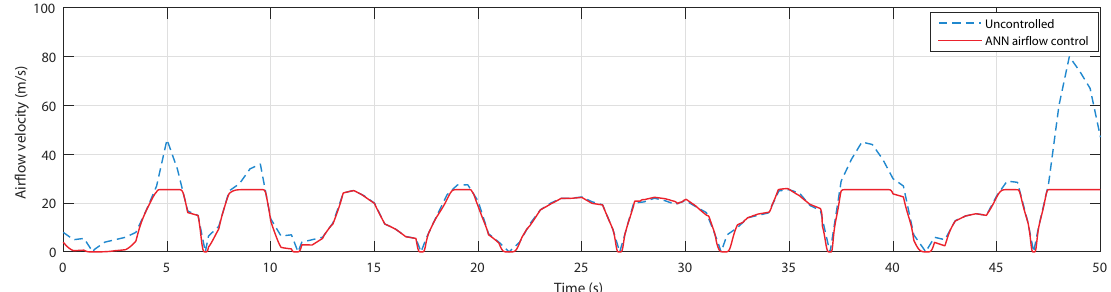
Figure 20. Airflow speed for uncontrolled case and ANN-based airflow